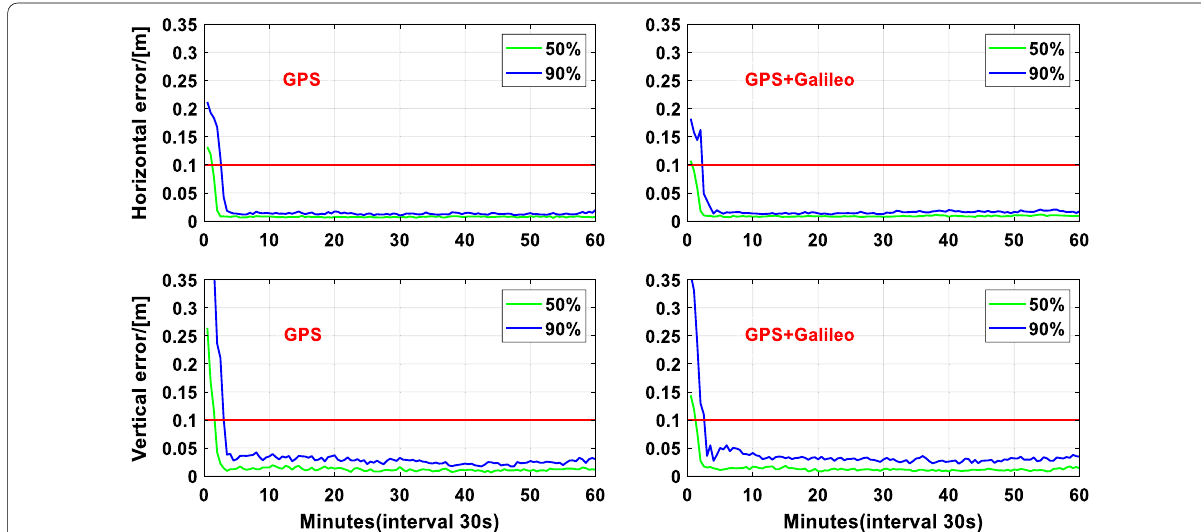
Fig. 8 Convergence performance of PPP-RTK user components for the medium-scale network at the 50% and 90% confidence levels. Top panel: horizontal error; bottom panel: vertical error. Left panel: GPS; right panel: GPS